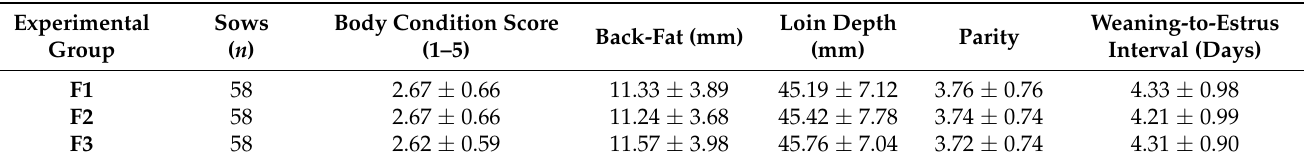
Table 3. Body condition score, back-fat thickness, loin depth, parity, and weaning-to-estrus interval (mean ± standard deviation) in sows from three experimental groups (F1, F2, F3).